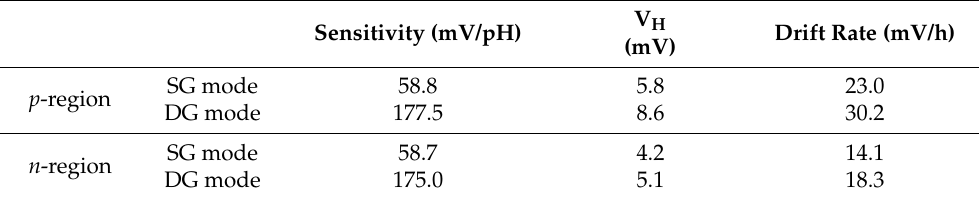
Table 1. pH sensing performance of the fabricated bipolar DG